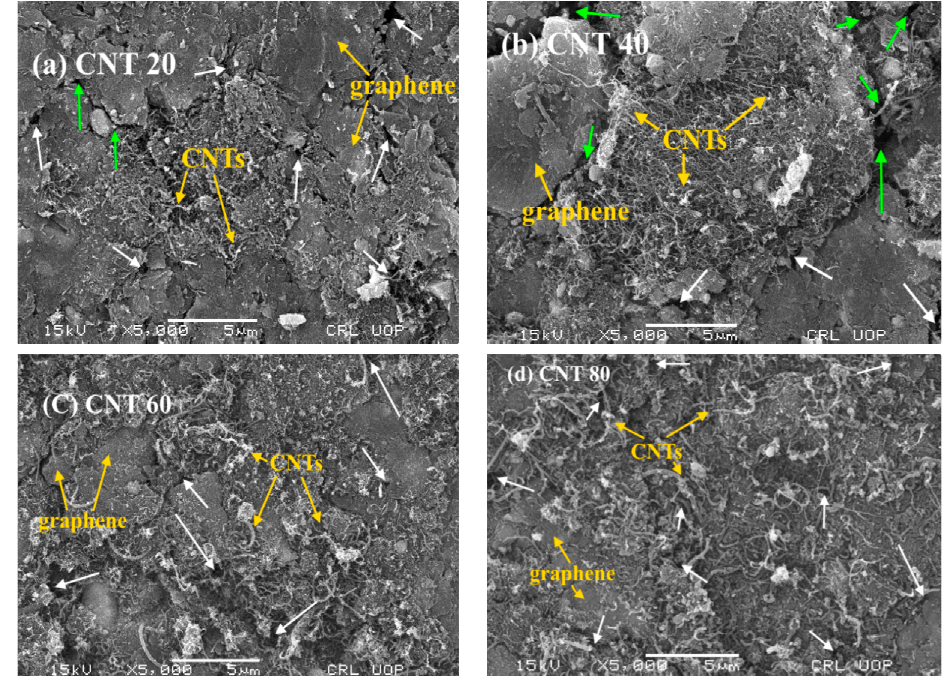
Figure 7. SEM images of CNT-graphene composite based piezoresistive pressure samples; ( a ) 20 wt% of CNTs, ( b ) 40 wt% of CNTs, ( c ) 60 wt% of CNTs, ( d ) 80 wt% of CNTs with cracks (green arrow) and voids/pores (white arrow).